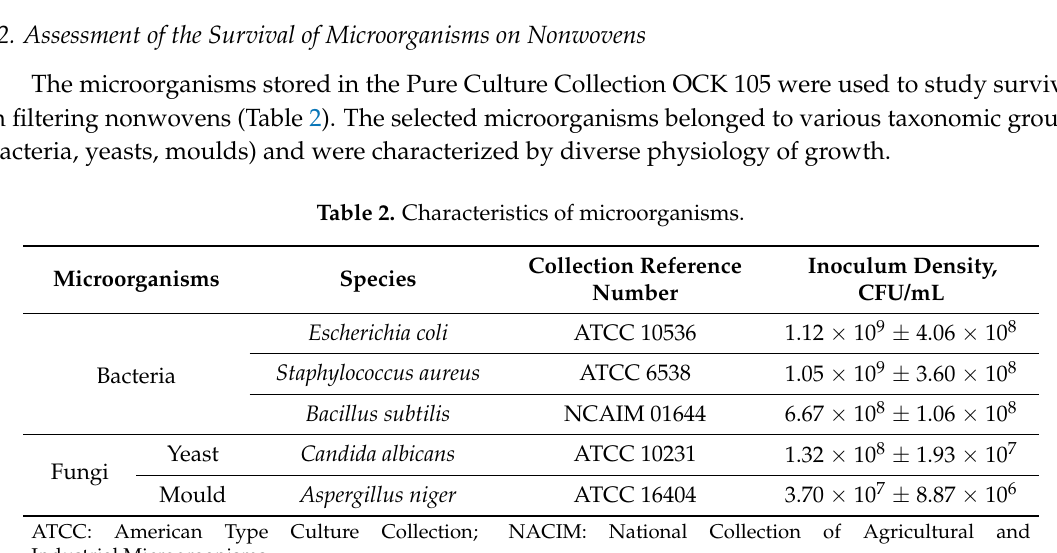
FFR : filtering facepiece respirator.